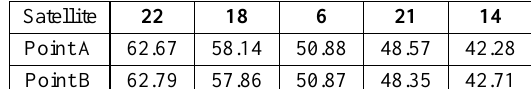
Figure 14. Experimental location. The data collected over 50 seconds between points A and B. Table 1. Satellite elevation angles (deg) at Points A and B.